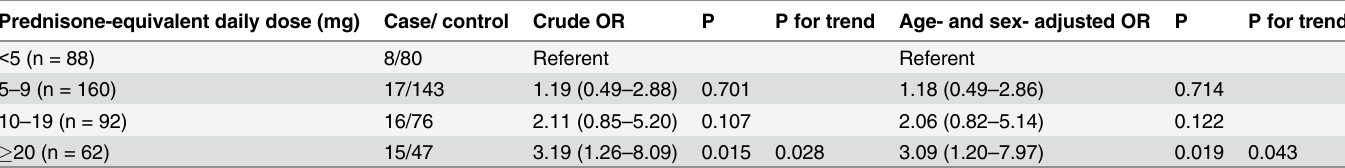
Table 5. Effect of prednisone-equivalent daily corticosteroid dose on risk for candida esophagitis in steroid users (n = 402 * ). Prednisone-equivalent daily dose (mg) Case/ control Crude OR P P for trend Age- and sex- adjusted OR P P for